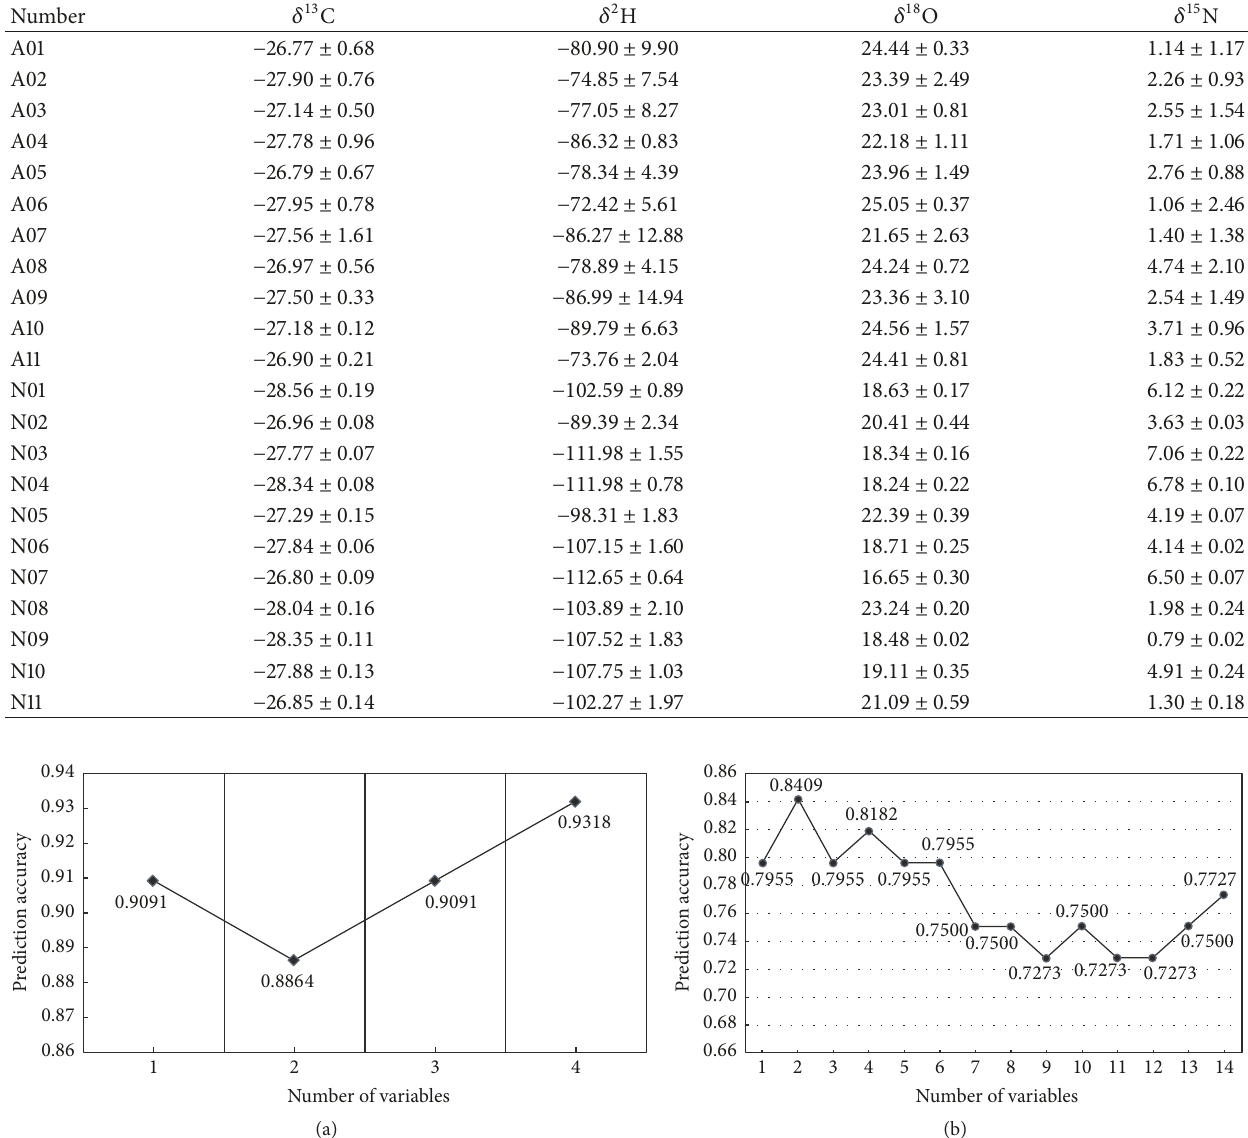
Figure 2: (a) Feature selection of isotope and prediction accuracy. (b) Feature selection of metallic element and prediction